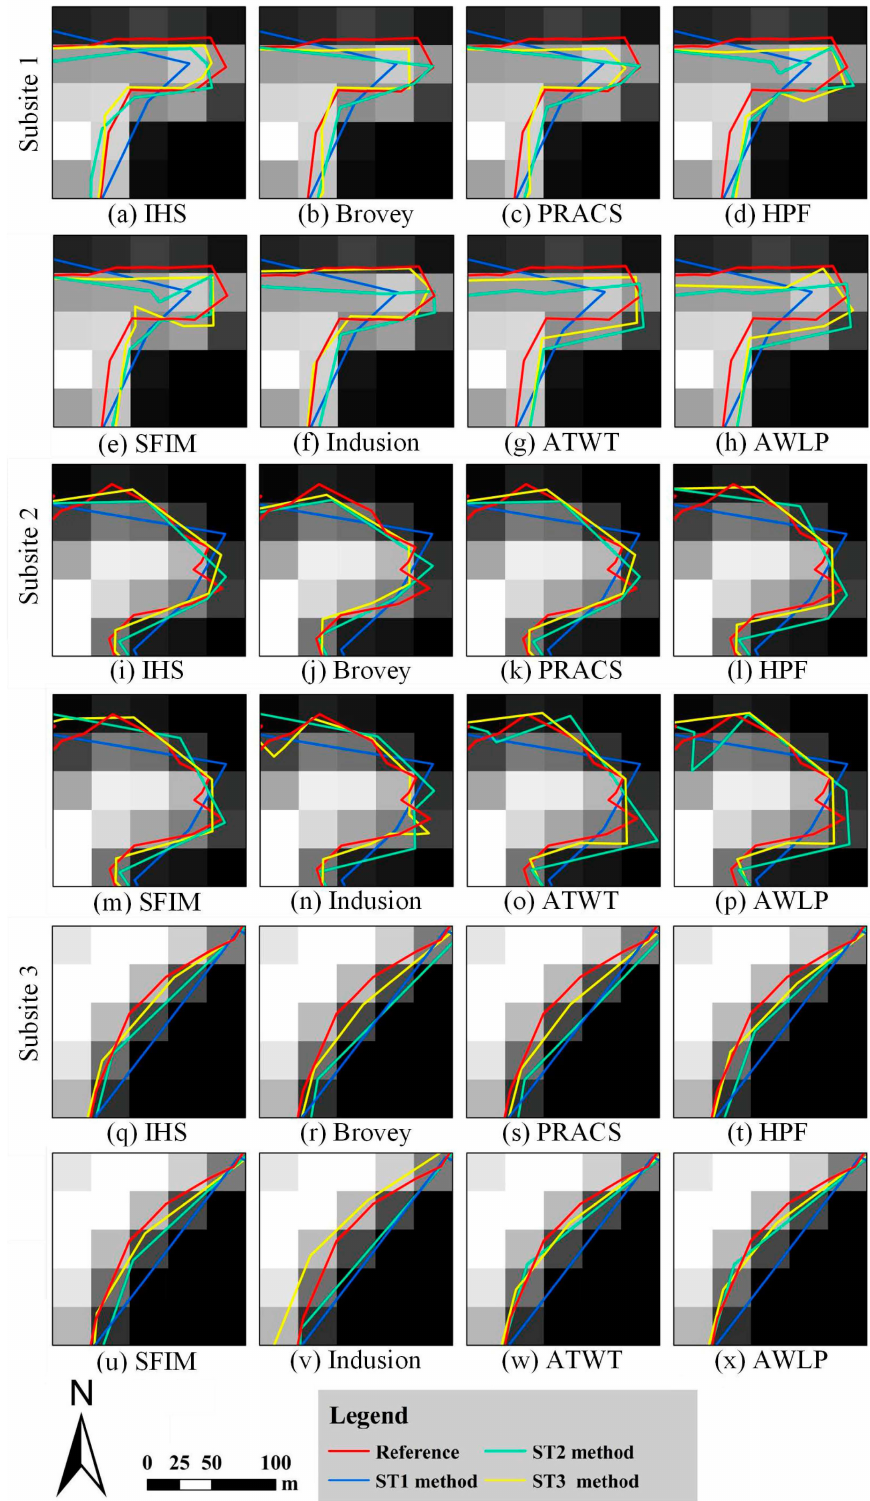
Figure 6. The position of coastlines extracted from three different strategies for three